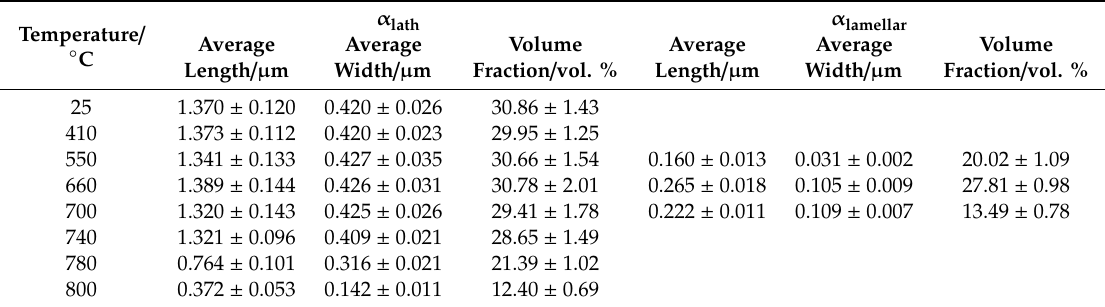
Table 2. Microstructure features of α phases quenched from di ff erent temperatures during 1 ◦ C / min